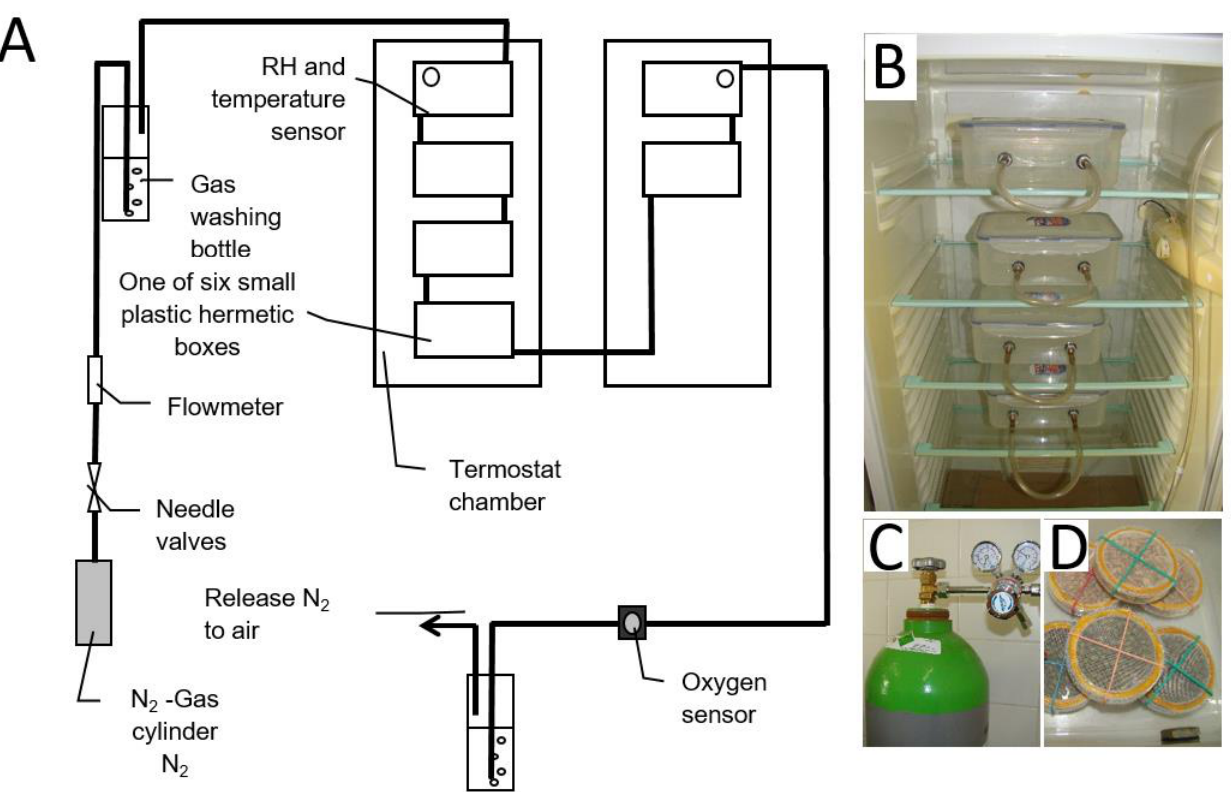
Figure 1. Testing apparatus for validation of nitrogen control atmospheres in laboratory conditions ( A ) — technical scheme; ( B ) — plastic boxes in a climatised thermostatic-chamber; ( C ) — source of N 2